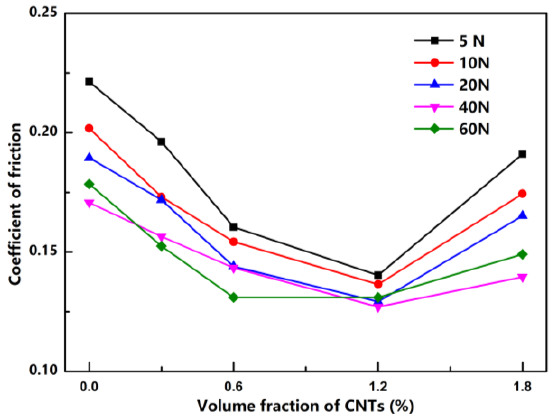
Figure 9. Average COF of pure Cu and Cu/CNT composites under different loading pressures and boundary lubrication conditions.